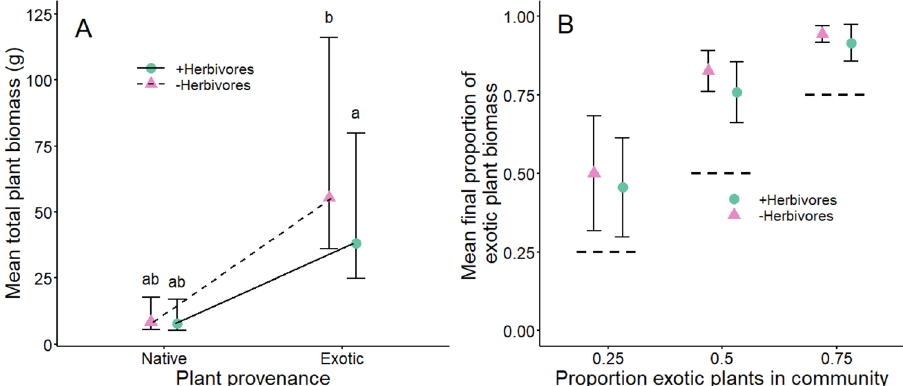
Fig. 3 In fl uence of the herbivore treatment on total plant biomass and the proportion of mesocosm biomass made up of exotic plants. A Exotic plants ( n = 211 and 206 in − Herbivore and + Herbivore mesocosms, respectively) produced 31% less total biomass in + Herbivore (green circles and solid line) compared with − Herbivore (pink triangles and dashed line) mesocosms ( P = 0.012, Bonferroni corrected pairwise Tukey test based on the plant provenance× herbivore treatment interaction: F 1,884 = 4.08, P = 0.044), whereas the herbivore treatment did not affect native plants ( P = 1.000, n = 273 and 261 in − Herbivore and + Herbivore mesocosms, respectively). Different lowercase letters indicate signi fi cant differences ( P < 0.05, based on Bonferroni corrected Tukey tests) between back-transformed estimated marginal means (±SEM) from linear mixed models. B The mean (±95% con fi dence intervals, n = 16) proportion of total mesocosm biomass that was made up of exotic plants was signi fi cantly higher than the expected proportion of exotic plant biomass (dashed lines, based on proportion of exotics planted in the community), regardless of herbivore treatment (pink triangles = − Herbivores; green circles = + Herbivores). Any 95% con fi dence intervals that do not overlap the respective dashed line are considered to be sign fi ciantly different from the expected proportion of exotic biomass. Corresponding violin plots showing the distribution of raw data are presented in Supplementary Fig. 16.